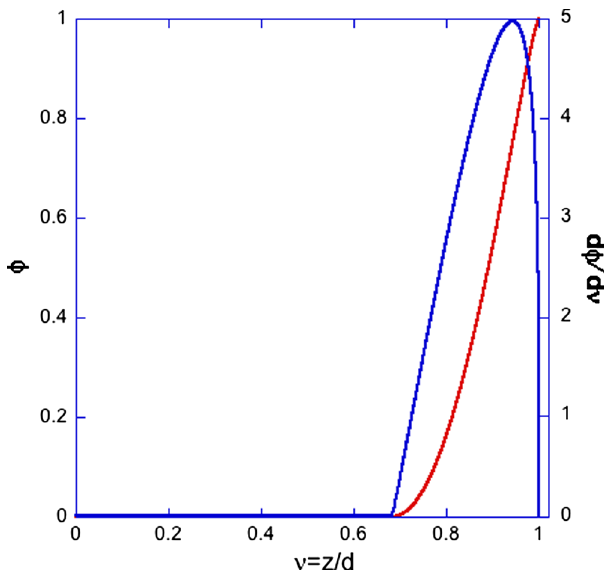
FIG. 6. Profile of dimensionless magnetic field for EX in the HE regime of Sec. II B 3, and Δ I ¼ 0 . 4 MA. See the text for the meaning of the